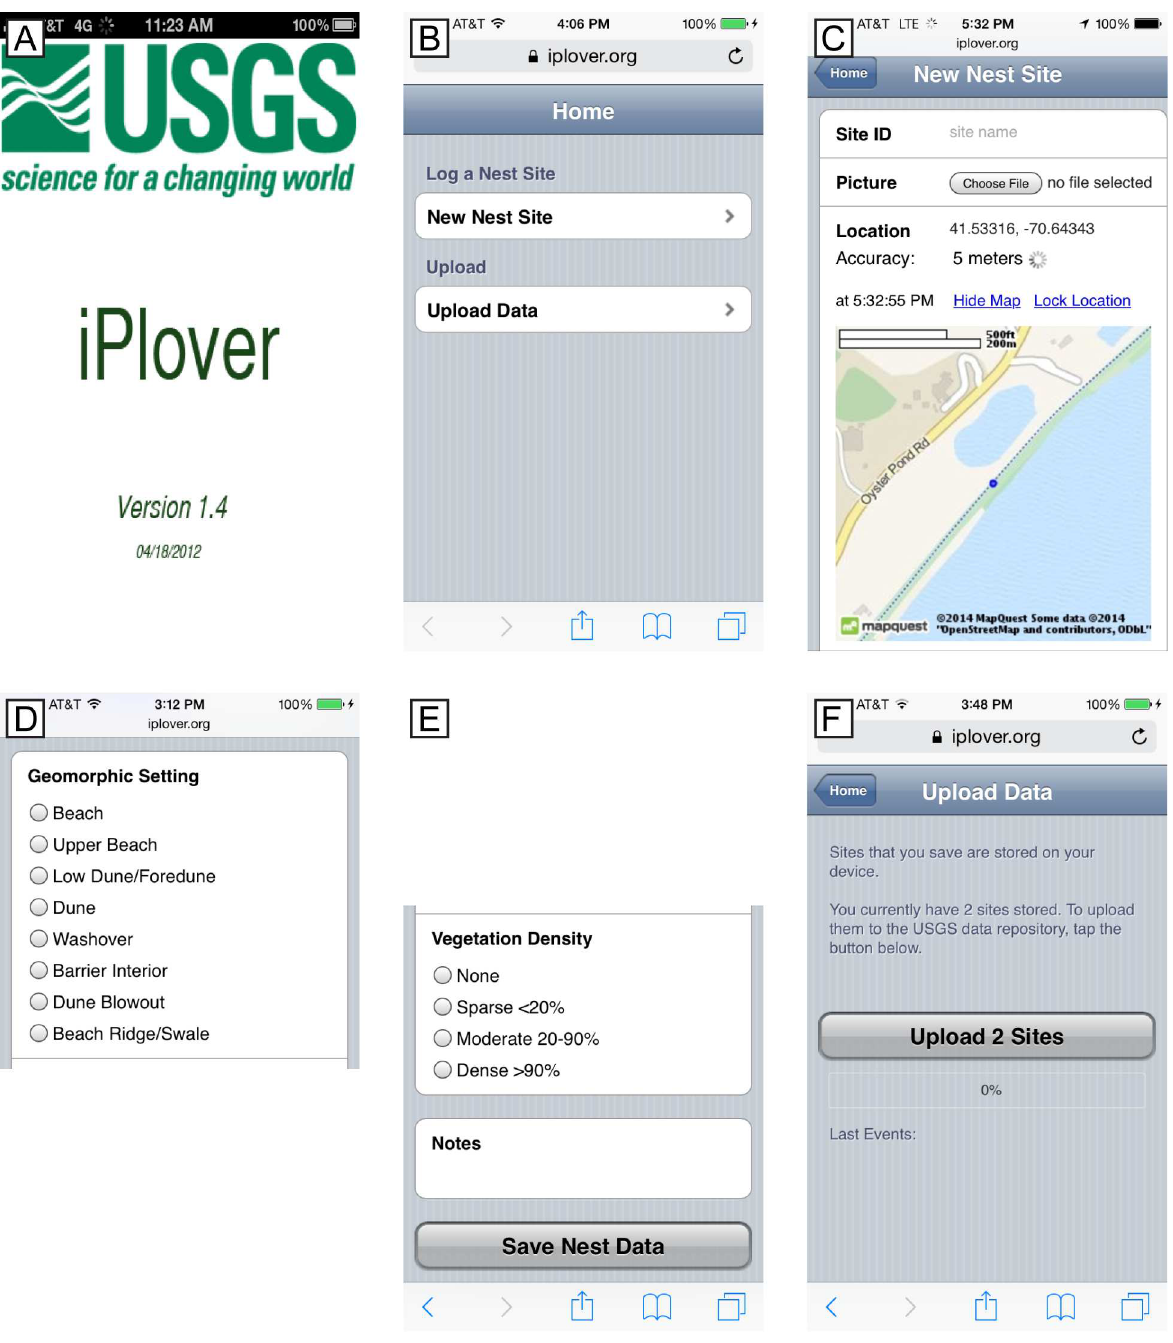
Fig 2. Screenshots showing the iPlover web application interface used during summer 2014. (A) Splash screen showing application name and version. (B) Home page with options to record a new observation ("nest site") or uploadexisting data. (C) Upper portion of the New Nest Site data entry page, showingsite identificationentry, photo capture button, and location functionality. (D) Middleportion of the New Nest Site data entry page, showingradio button selection options for the site’s geomorphic setting. (E) Lower portion of the New Nest Site data entry page, showingradio button selection options for vegetation density, the notes field, and "save" button. (F) Upload data page, showingnumber of samplingdata points currently stored on the device, a button to initiate data transfer, and a progress bar to indicate